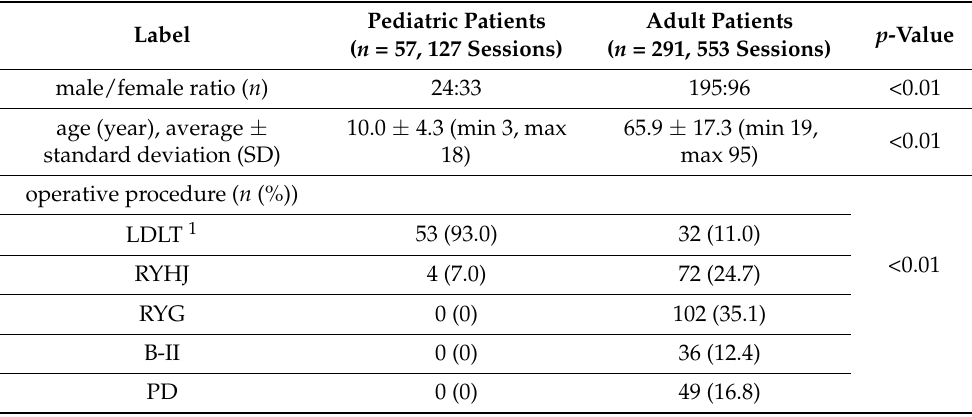
Table 1. Clinical profiles of enrolled